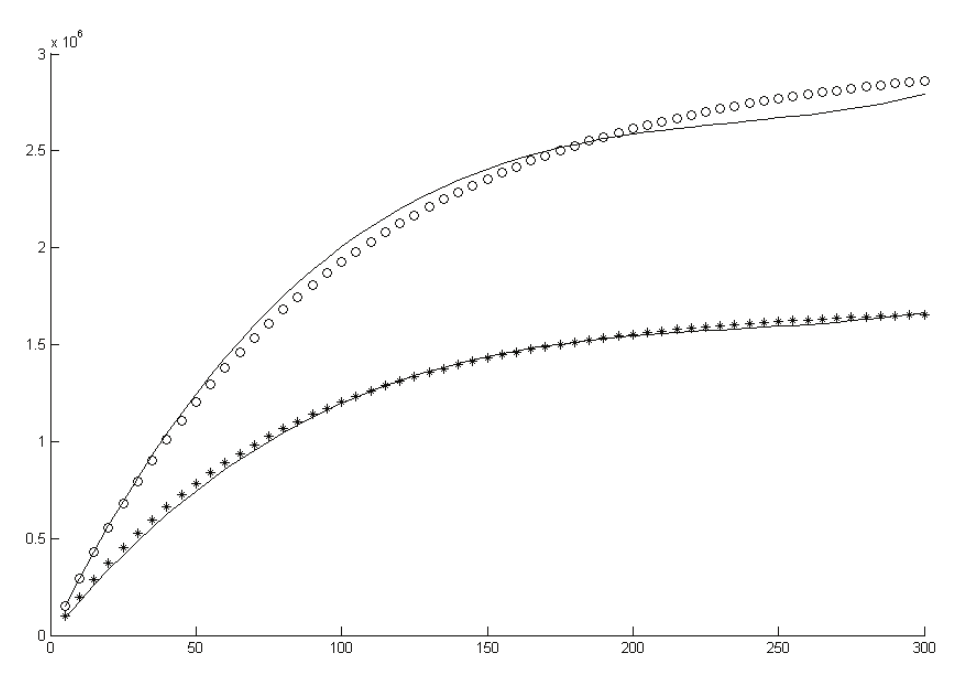
figure 9. The fitting curve when θ = 45000 and